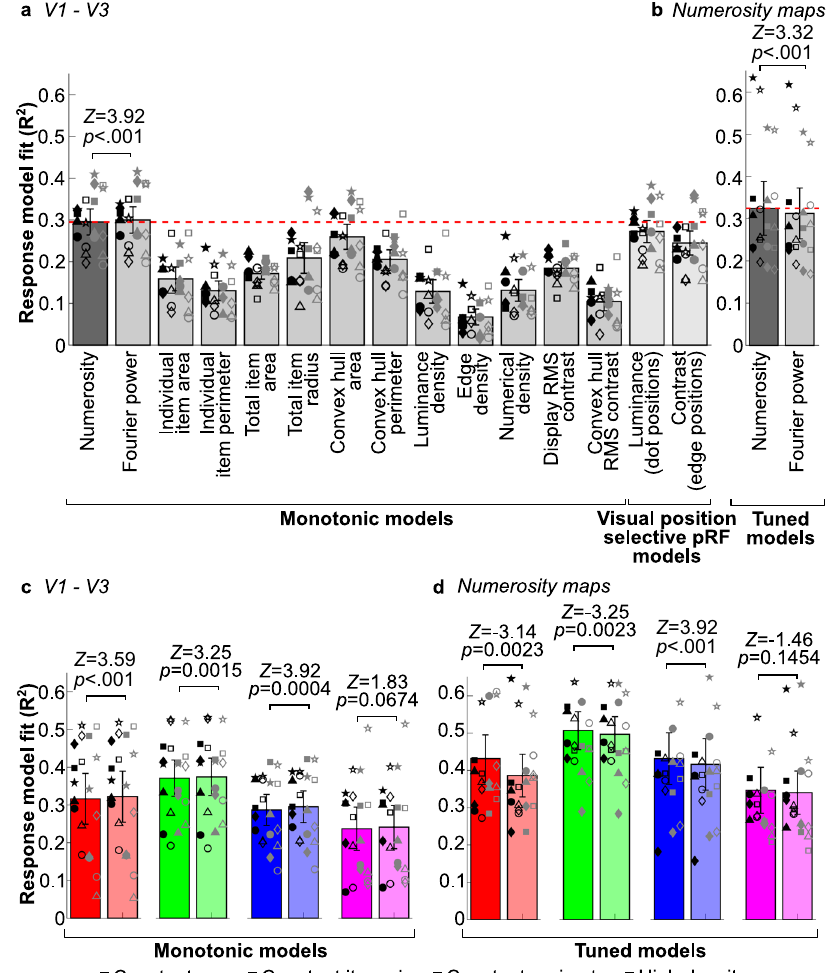
Fig. 5 Responses to aggregate Fourier power predict early visual monotonic responses better than numerosity, but numerosity predicts tuned responses better. a Variance explained by monotonic response models for numerosity and non-numerical visual features, and visual position selective pRF models in V1 – V3. A monotonic response model for aggregate Fourier power predicts observed responses better than all other response models ( p < .001). b Variance explained by tuned response models for numerosity is greater than that for a tuned response model for aggregate Fourier power in the association cortex numerosity maps ( p < 0.001). c Variance explained by monotonic response models for numerosity (saturated bars) and Fourier power (unsaturated bars) in V1 – V3 in each stimulus con fi guration. d Variance explained by tuned response models for numerosity and Fourier power in the association cortex numerosity maps in each stimulus con fi guration. Bar height is the mean variance explained across all maps. Error bars show 95% con fi dence intervals, re fl ecting the range of fi ts between individual maps, n = 20 hemisphere measurements (ten hemispheres, examined over two independent measurements). Markers show the median variance explained for each measure: different shapes are different participants; fi lled and un fi lled symbols are odd and even runs; black is left hemisphere and gray is right hemisphere. P -values show signi fi cance of differences in paired, two-sided Wilcoxon signed-rank tests, FDR corrected for multiple comparisons. Source data are provided as a Source Data fi le, with response time courses and all model fi ts for each voxel in the ROIs provided online (see “ Data availability ”